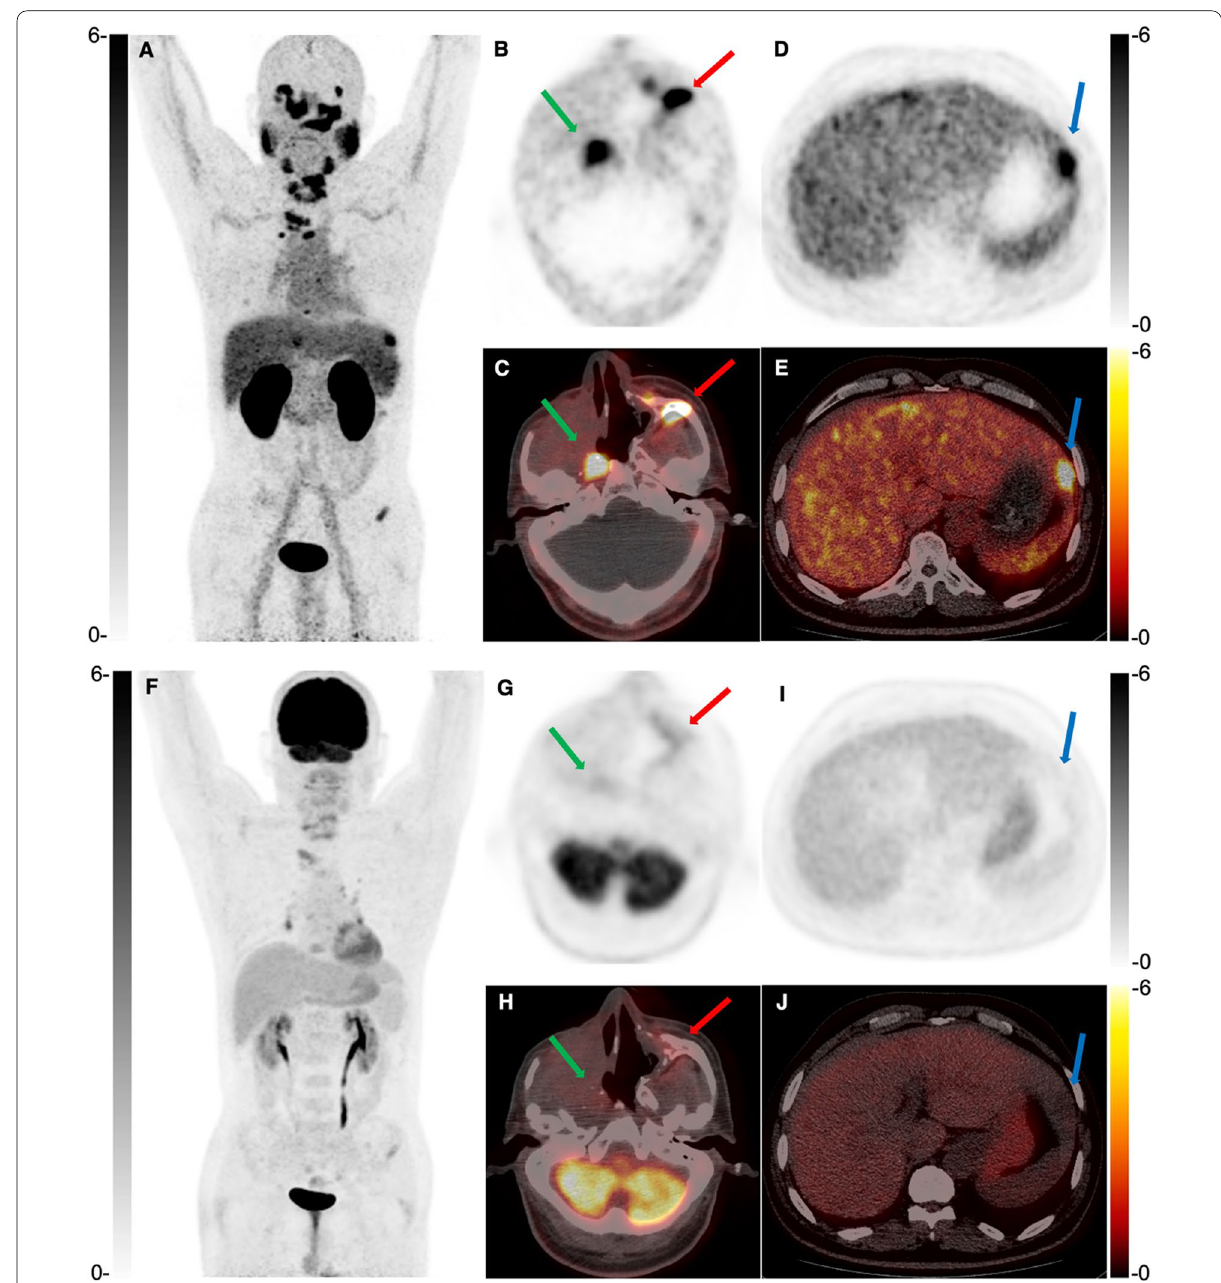
Fig. 3 A 62-year-old man was diagnosed with local recurrence and distant metastases 21 months after surgical removal of a right maxillary sinus ACC. 68 Ga-PSMA PET/CT ( A – E ) revealed a PSMA-avid tumor in the right maxillary sinus (green arrow, SUVmax 11.2), multiple bone metastases (red arrow, SUVmax 16.2), and liver metastases (blue arrow, SUVmax 8.8). 18 F-FDG PET/CT ( F – J ) showed negative recurrent and metastatic